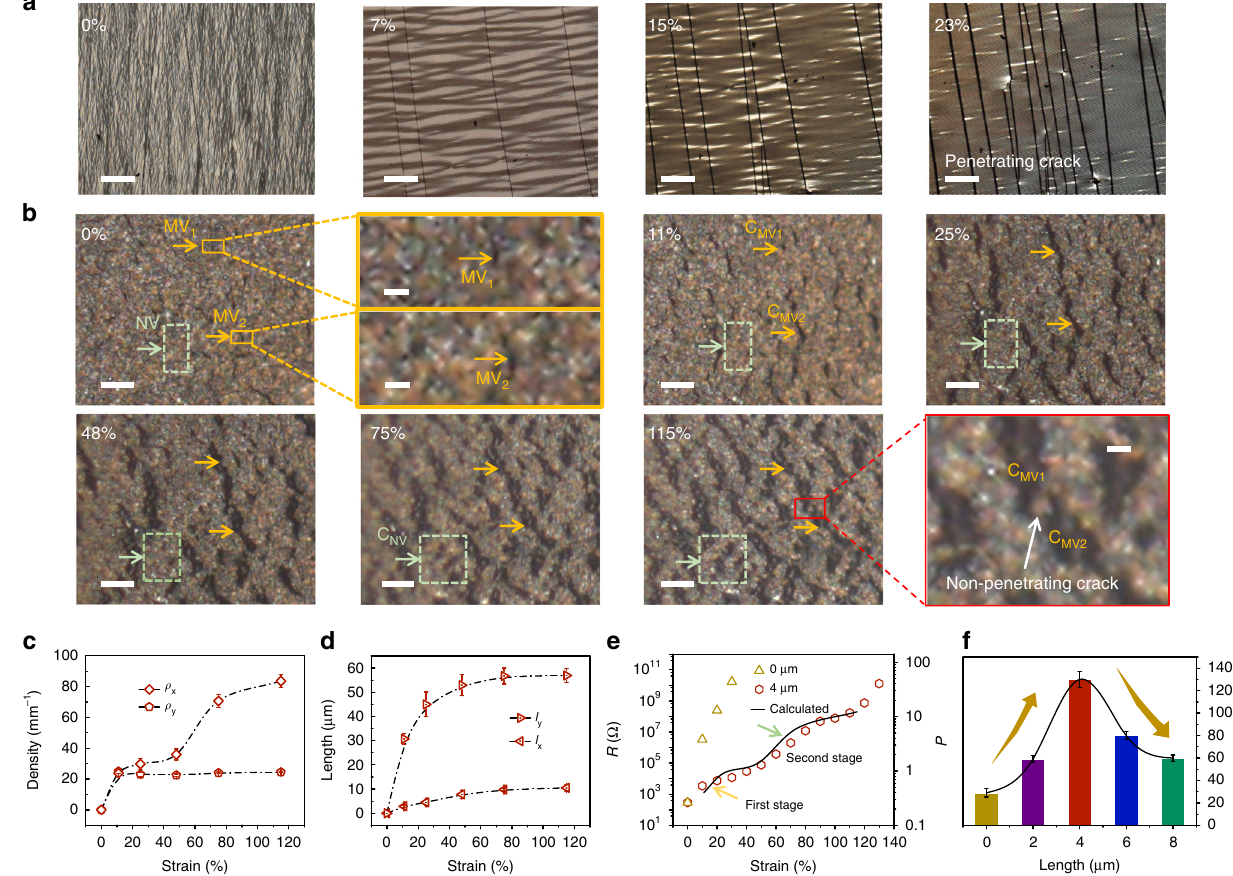
Fig. 3 In fl uence of strains on morphology and electrical resistance of Pt fi lms. a , b In-situ imaging of cracking process of Pt fi lms coated on ( a ) a fl at surface or ( b ) a nanowire-structured surface at different strains, respectively (two MVs and corresponding C MV are marked with yellow arrows or box; NV region and corresponding C NV are marked with greed dashed box; scale bar in a , 200 μ m; scale bar in b , 20 μ m; scale bar of enlarged fi gures of 0% and 115% strain in b , 5 μ m). c , d Linear density and length of cracks of the Pt fi lm coated on hierarchical assemblies of 4- μ m-length nanowires plotted as a function of strains. Subscripts x and y represent the directions parallel and perpendicular to the stretch, respectively. Error bars, s.d. ( n = 20). e Electrical resistance of the Pt fi lm and calculated P ( ρ x l x / ( l 0 - ρ y l y )) as a function of strains (see Supplementary Note 4 for details). f Tolerable strain as a function of nanowire length. Error bars, s.d. ( n =